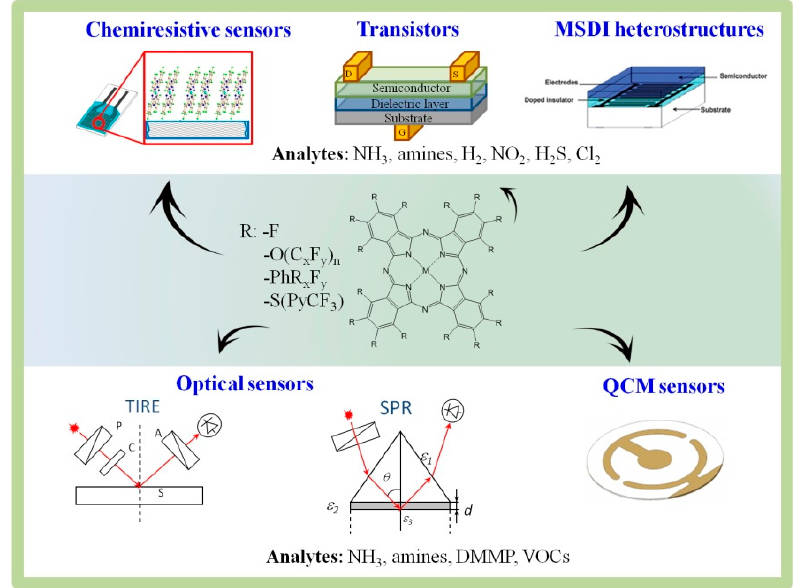
Scheme 1. Schematic representation of the application of fluoro-substituted metal phthalocyanines as active layers of gas